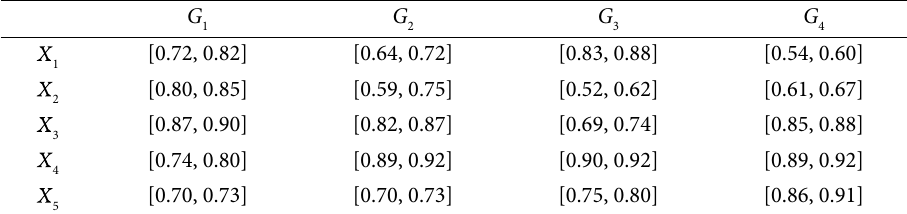
Table 3. Decision matrix 3 A